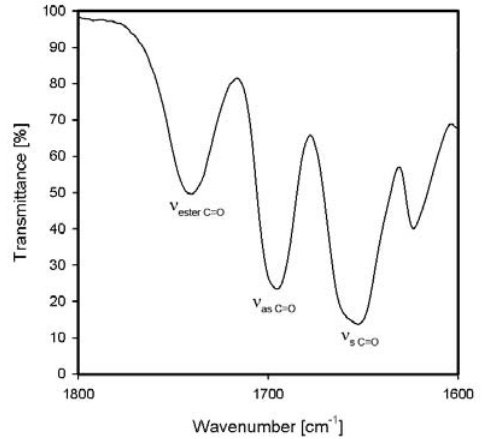
For N -(2-ethoxy-2-oxoethyl)- N,N -bis[3-(1,8-naphthalimido)propyl]- N -propylammonium iodide ( NP8 ), apart from bands of carbonyl groups of dicarboximide ring, new symmetric stretching vibration band of carbonyl group appears at 1741 cm − 1 (Table 1, Figure 4). This band has no imide character and comes from carboethoxy substituent. Figure 4. FTIR spectrum of carbonyl range of N -(2-ethoxy-2-oxoethyl)- N,N -bis[3-(1,8- naphthalimido)propyl]- N -propylammonium iodide ( NP8